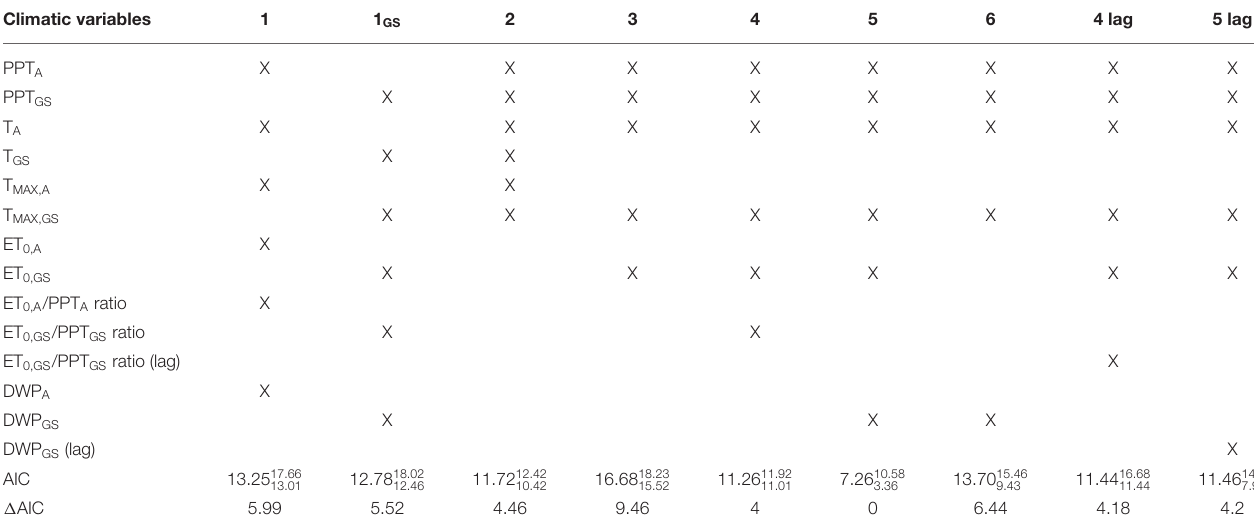
TABLE 2 | Combinations of climatic variables considered in each PLS analysis and median, maximum, and minimum AIC score attached to each combination of climatic variables over the study site. Climatic variables